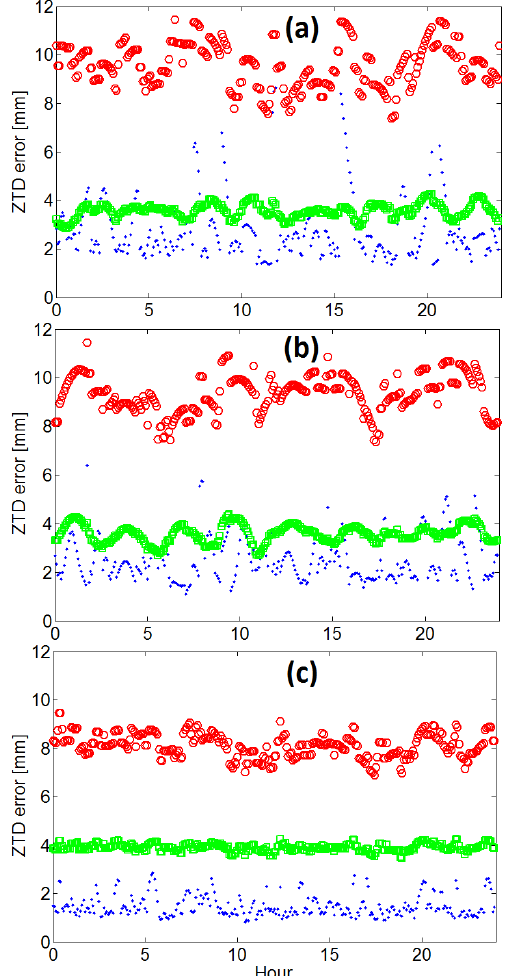
Figure 2. The ZTD error due to orbit errors for three GRUAN sites: (a) LDB0, (b) LDRZ, and (c) NYA2, where the blue dots show the simulated ZTD error, the red circles show the theoretical ZTD error caused only by the radial orbit error, and the green squares show the theoretical ZTD error caused only by the tangential orbit